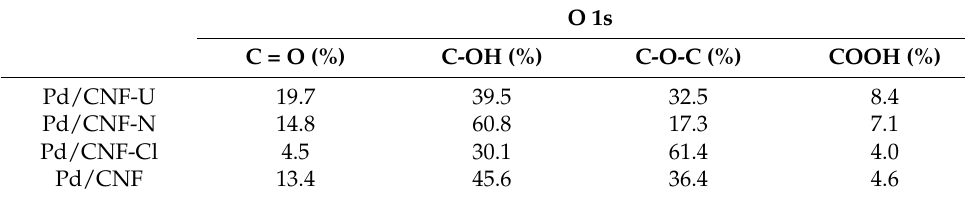
Table 3. Distribution of oxygen-containing species on the catalysts.